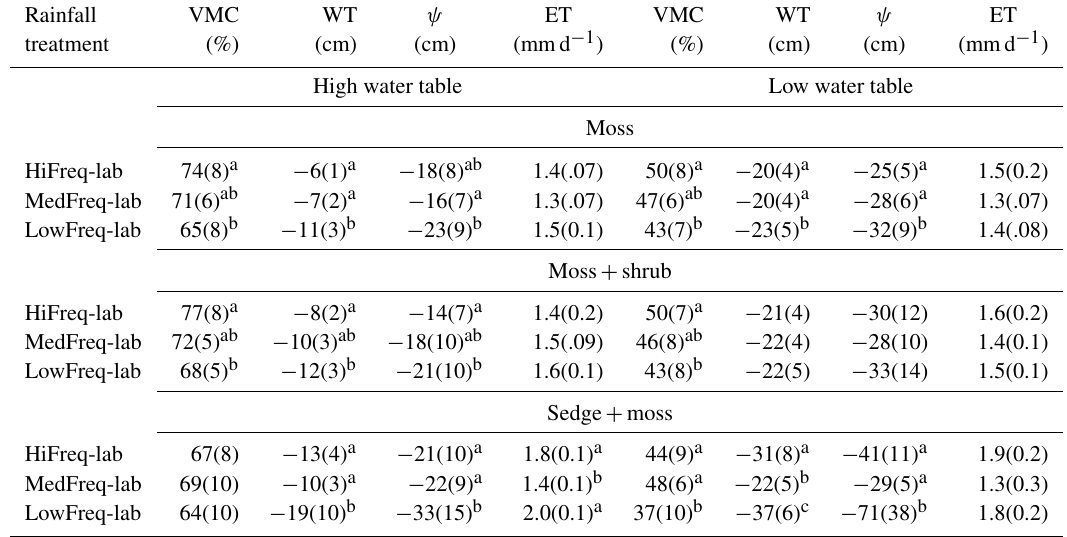
Table 1. Mean ( ± standard deviation) values of volumetric moisture content (VMC), water table (WT), soil matric tension ( ψ ), and evapo- transpiration (ET) for each precipitation, WT, and vegetation community treatment during the laboratory experiment. Different letters indicate significant differences ( p < 0 . 05) between precipitation treatments within each water table and vegetation treatment. No letter indicates no significant